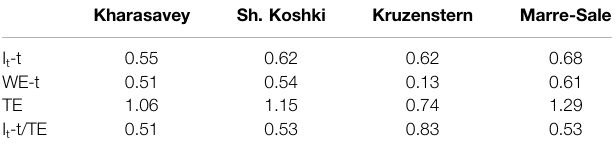
TABLE 3 | I t and WE long-term values transformed to 0 – 1 scale by dividing them bythe0.975maximumvaluesforfoursites,theirsum(TE),andtherelativerole of thermal denudation in coastal destruction (I t